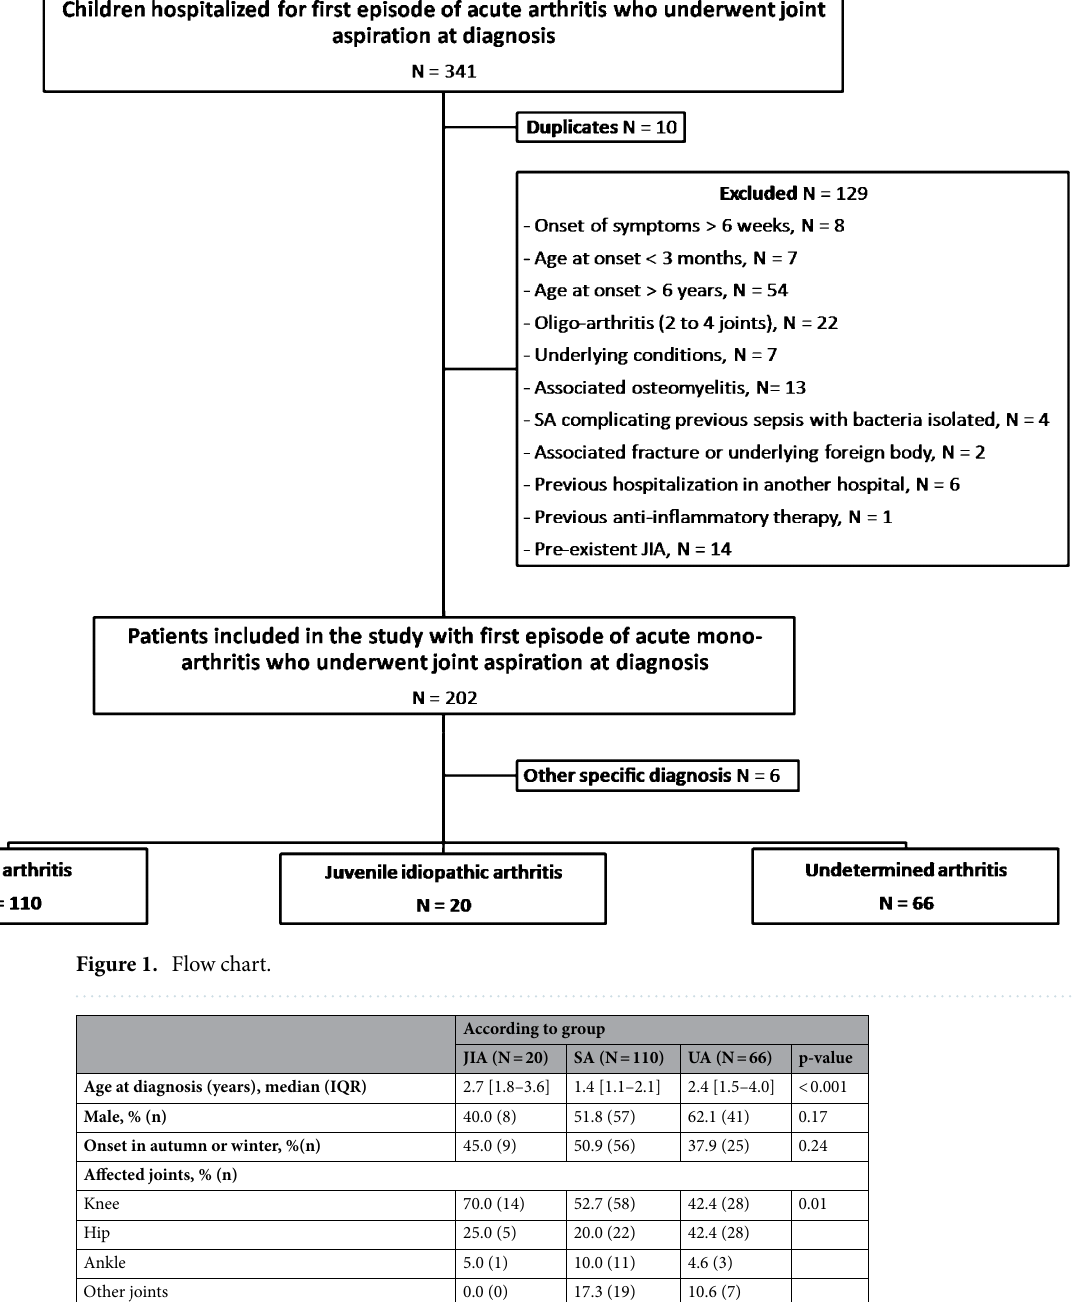
Table 1. Clinical characteristics of children with septic arthritis, juvenile idiopathic arthritis and arthritis with no definitive diagnosis. SA septic arthritis, JIA juvenile idiopathic arthritis, UA undetermined arthritis a , IQR interquartile range. a Arthritis with no established association with infection that did not fulfil the classification criteria for JIA or other well-established